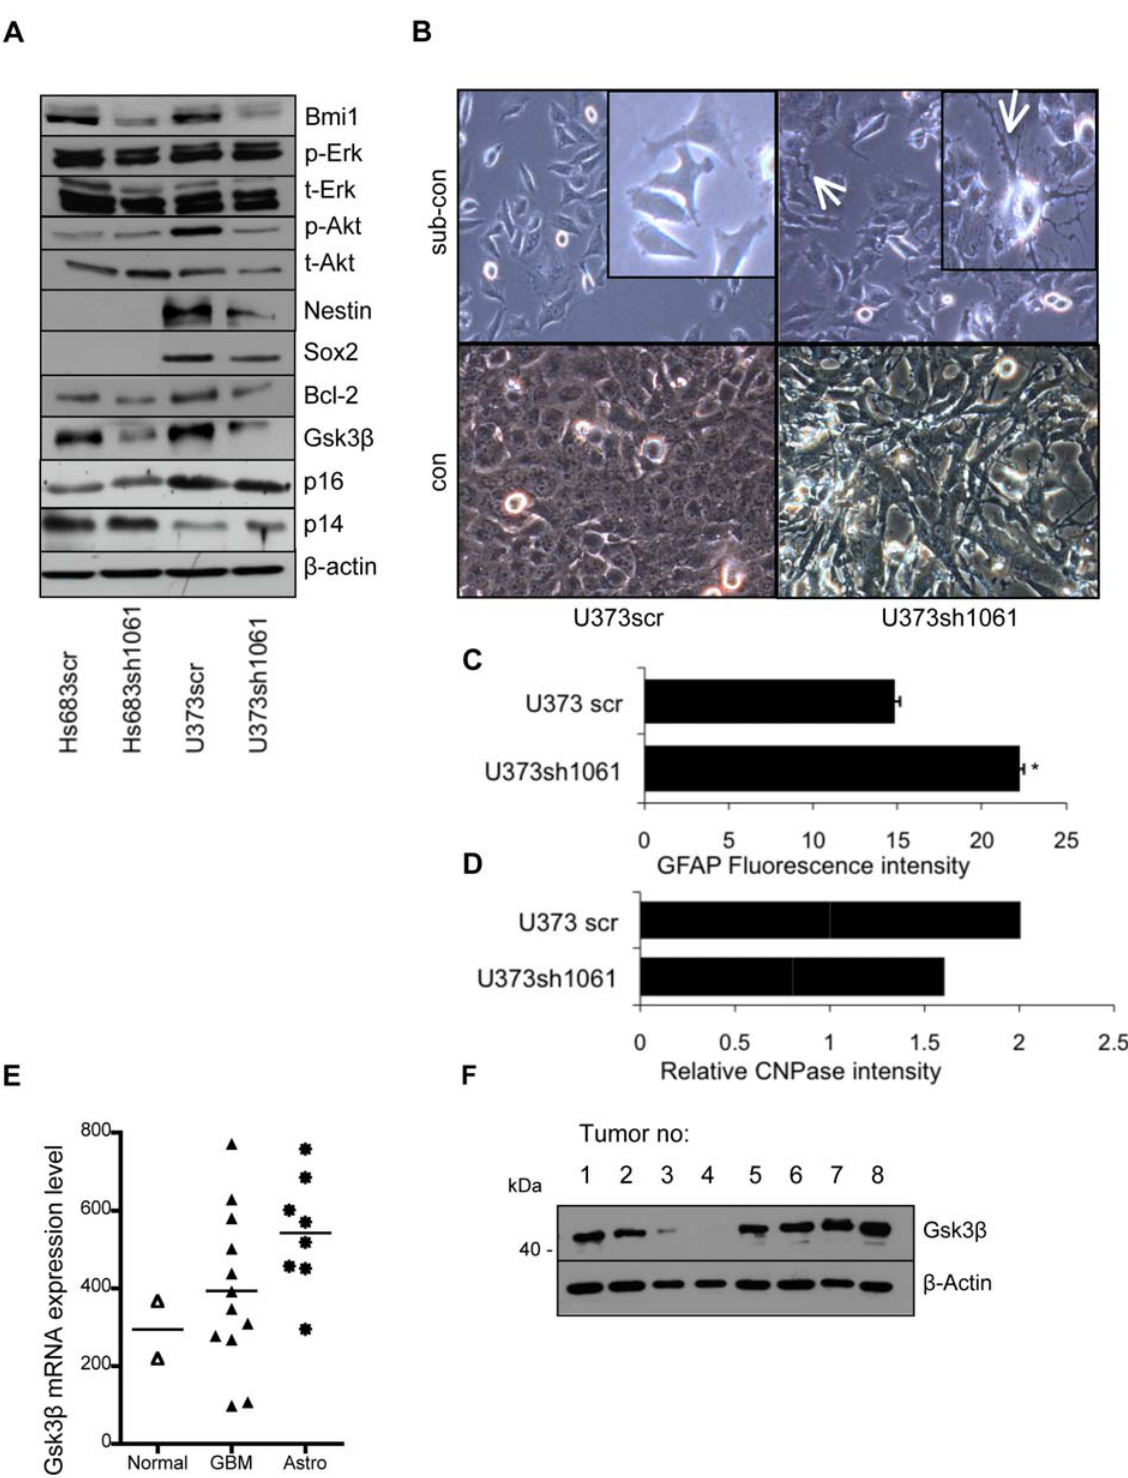
Figure 2. GSK3 b was downregulated by reduction of Bmi1 expression. (A) GBM cell lines U373 and Hs683 transduced with shRNA against Bmi1 (sh1061) or with scrambled shRNA (scr). Bmi1 downregulation induced downregulation of the following proteins: p-AKT, Nestin (in U373), Bcl2, and GSK3 b . No effects are evident on the p16/p14 ARF , or p-ERK protein levels. (B) Scrambled control or U373 Bmi1-downregulated cells at subconfluency (sub-con) or confluency (con). Bmi1-downregulated cells show differentiated morphology (arrow: long, branched processes). (C) The glial fibrillary acidic protein (GFAP) levels in U373scr and U373sh1061 cells measured by flow cytometry. (D) Relative CNPase protein levels in U373scr and U373sh1061 measured by western blotting, quantified using ImageJ software and normalized to b -actin levels. (E) GSK3 b mRNA values from a series of primary brain tumors (GBM and astrocytoma) and normal brain. (F) GSK3 b protein is expressed in primary GBM. * P , 0.05; one-way ANOVA (Newman-Keuls Multiple Comparison Test).